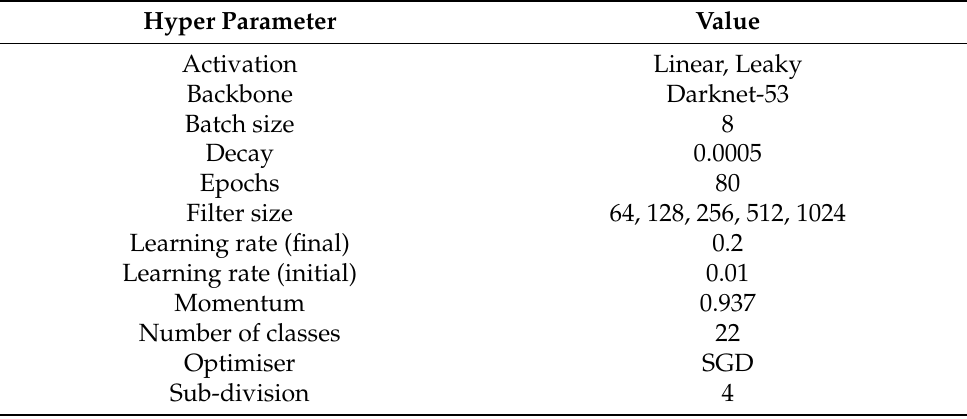
Table 3. Training parameters and their values for the deep neural